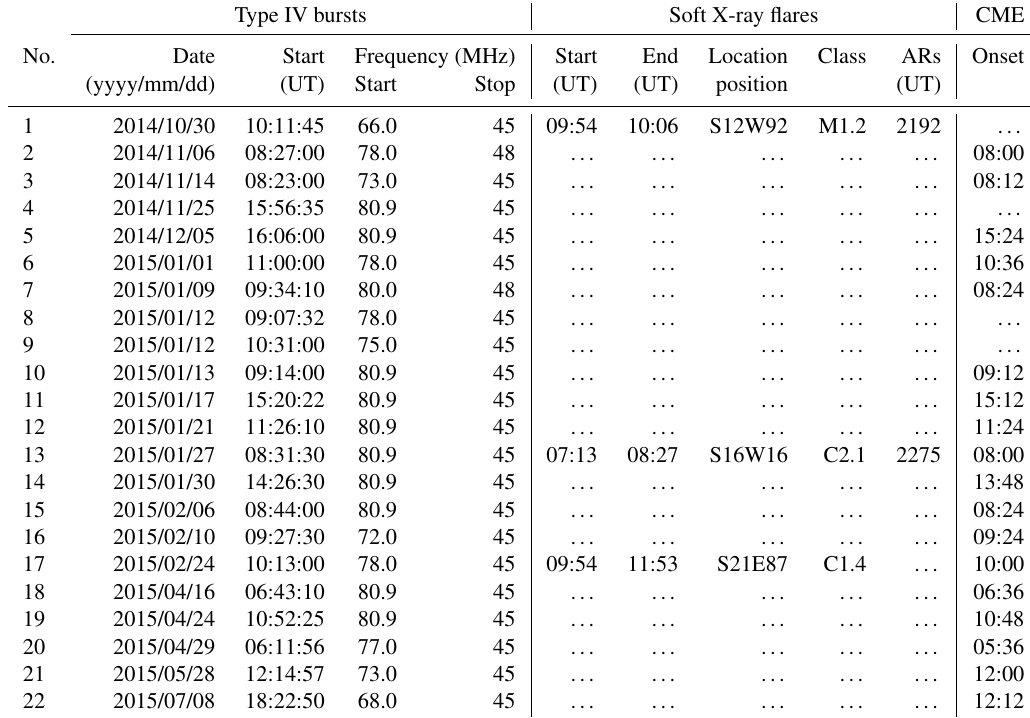
Table 2. Type IV SRBs observed by the CALLISTO spectrometer at the Kigali station.